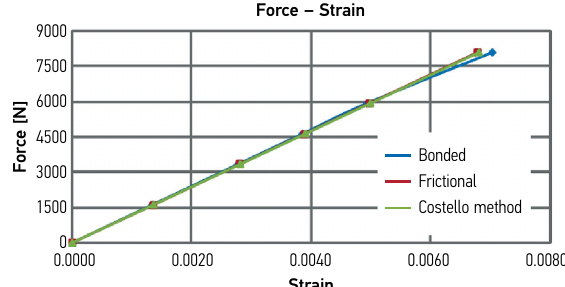
Fig. 7. Boundary conditions for 1 × 19 wire rope core